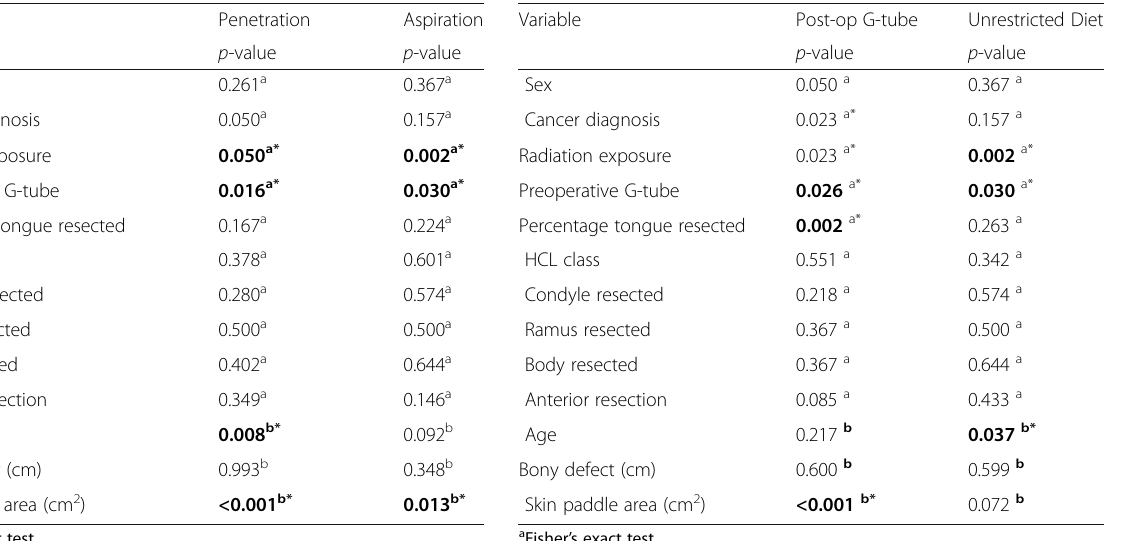
these same variables, in addition to the patient ’ s age ( p = 0.008). Table 5 summarizes the clinical predictors for long-